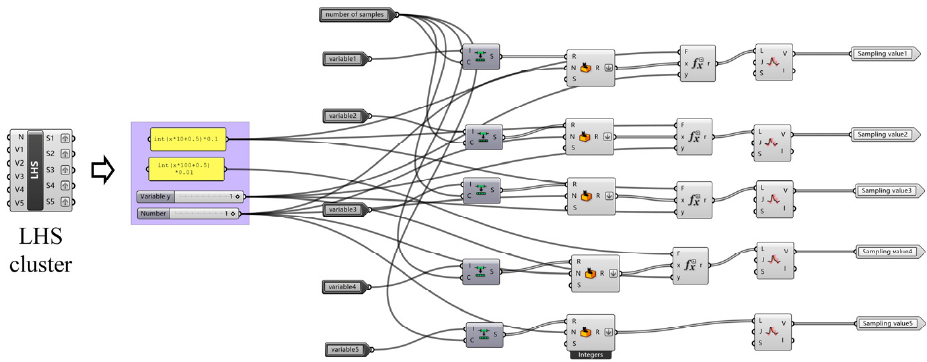
Figure 2. The battery diagram of the Latin hypercube sampling method based on GH.